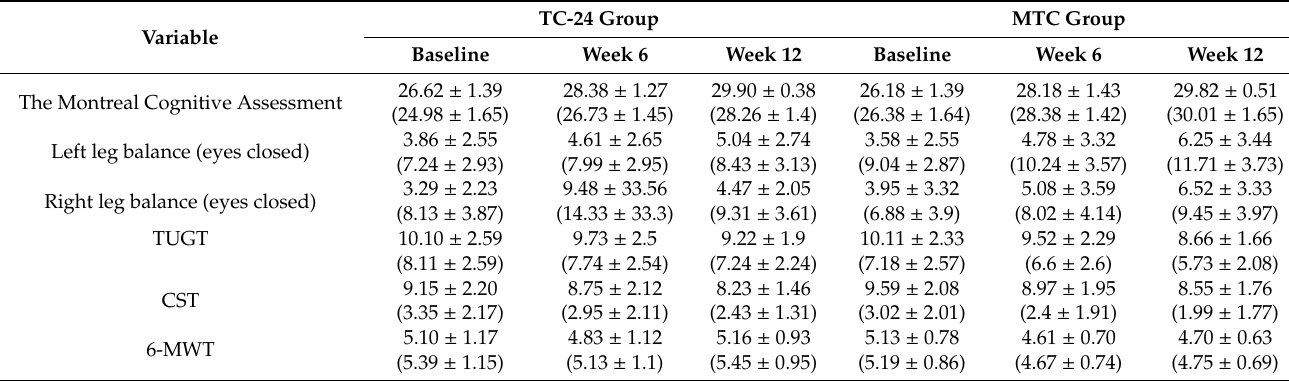
Table 3. Mean and standard deviation (M ± SD) of the raw data values and the data values adjusted for confounder e ff ects (the latter are given in parentheses), for cognitive function, balance, and physical fitness indices at baseline, Week 6, and Week 12 in the TC-24 group and MTC